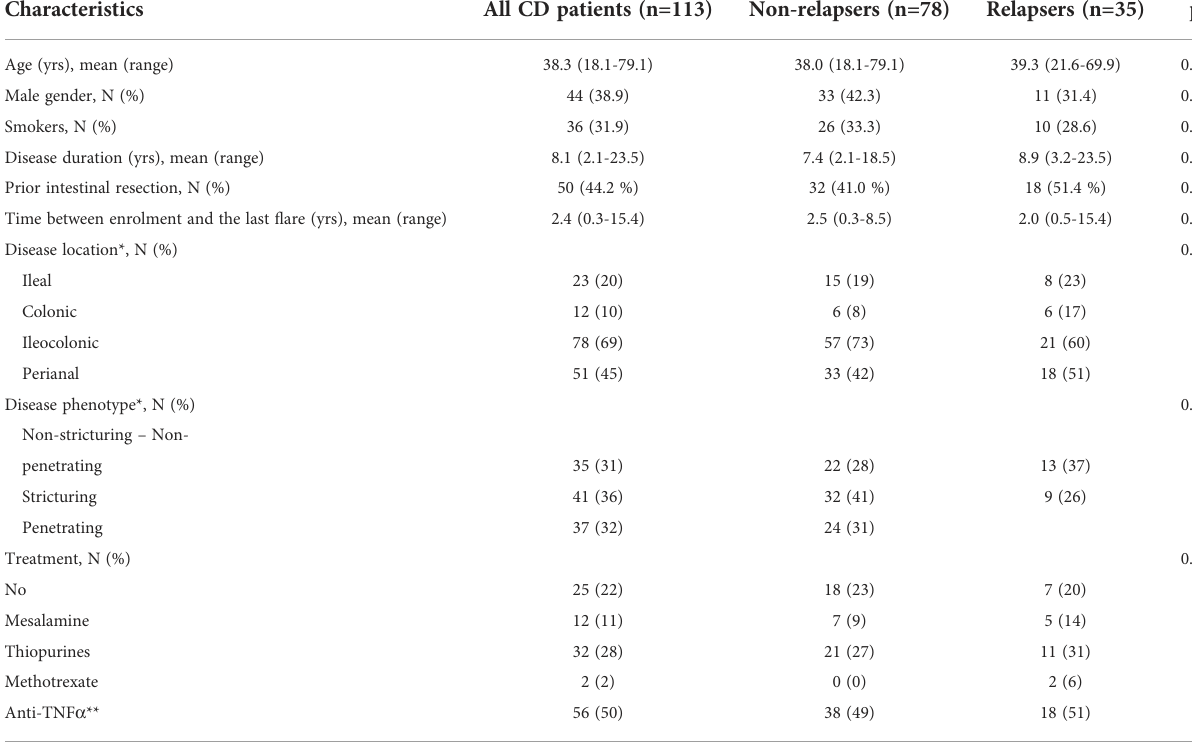
TABLE 1 Baseline characteristics of the cohort of CD patients. P-value is calculated by comparing non-relapsers and relapsers.